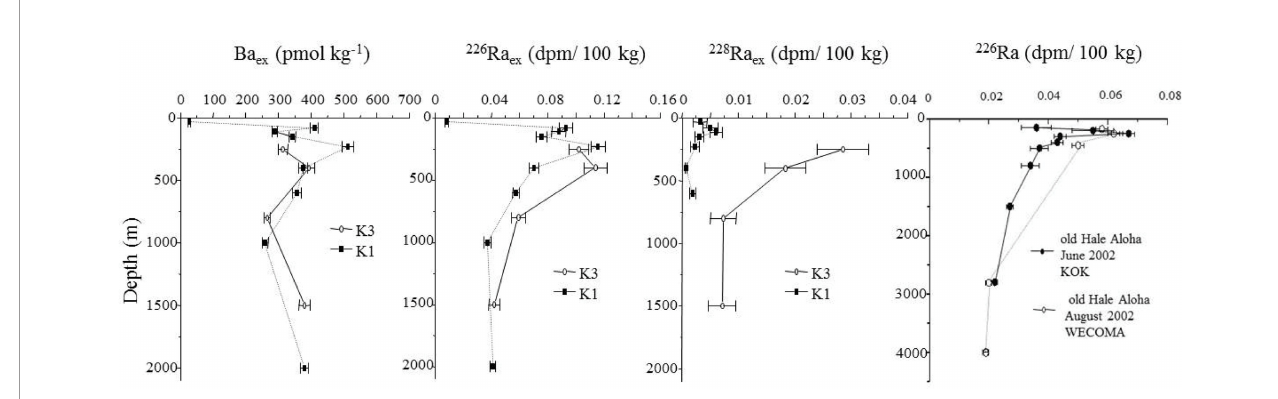
FIGURE 5 | Vertical pro fi les of excess Ba (Ba ex ) concentrations, excess 226 Ra ( 226 Ra ex ) activities and excess 228 Ra ( 228 Ra ex ) determined in suspended particles collected at stations K1 and K3. We also report the 226 Ra activities (not corrected for the supported 226 Ra) determined in the suspended particles collected at old station Hale Aloha in June and August